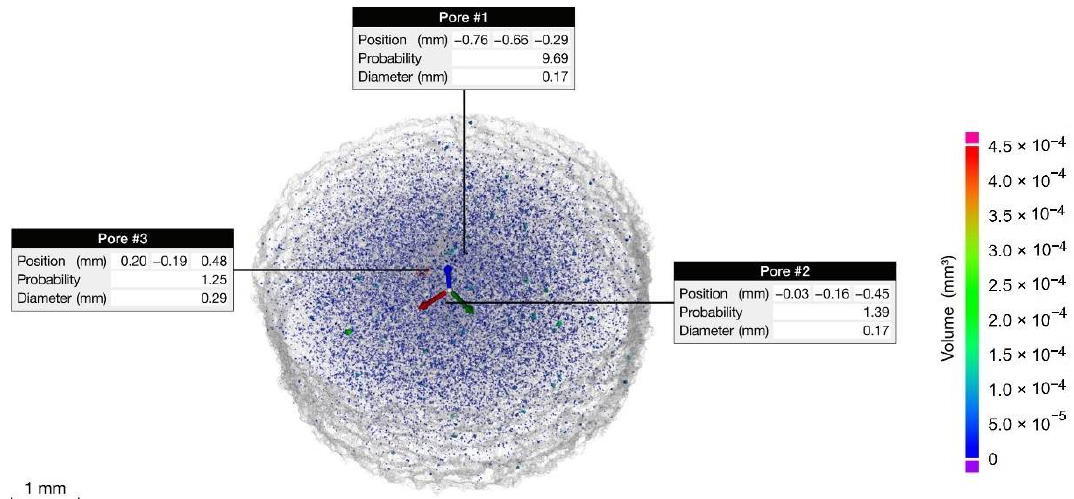
Figure 3. Volumetric distribution of the pores in the analyzed section.